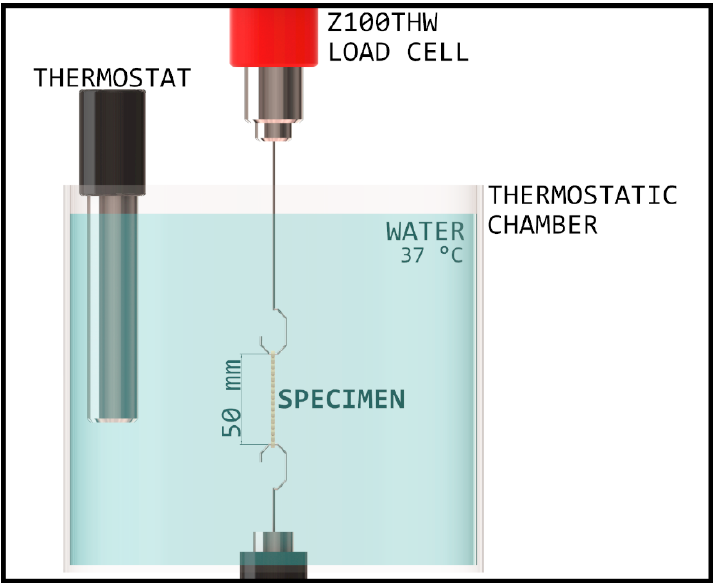
Figure 1. Schematic diagram of the thermostatic chamber, with an established environment corre- sponding to the oral cavity.